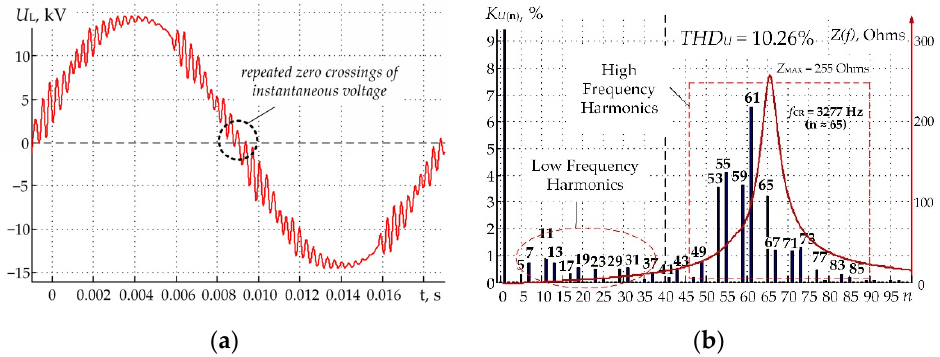
Figure 11. The immediate values of the line voltage in the 10 kV buses ( a ) and their harmonic spectrum ( b ).